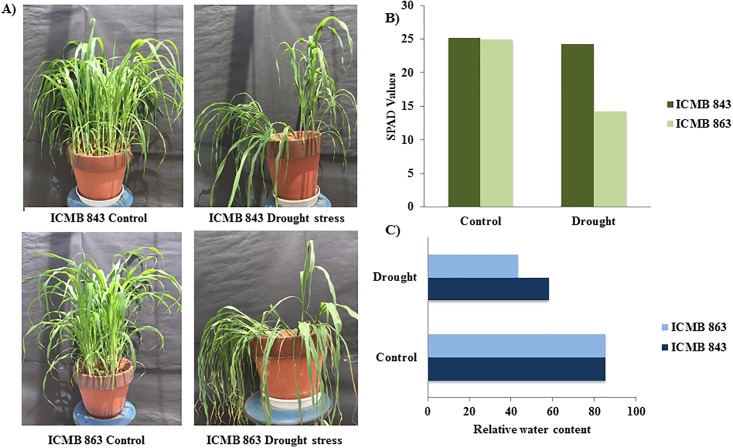
Physiological analysis of pearl millet for drought.A) Effects of drought on the physiology of pearl millet lines (ICMB 843 and ICMB 863). B) SPAD value of pearl millet lines under and drought conditions. Values are mean ± SE (n = 20) C) Relative water content of leaf under control and drought stress. Values are mean ± SE (n = 20).